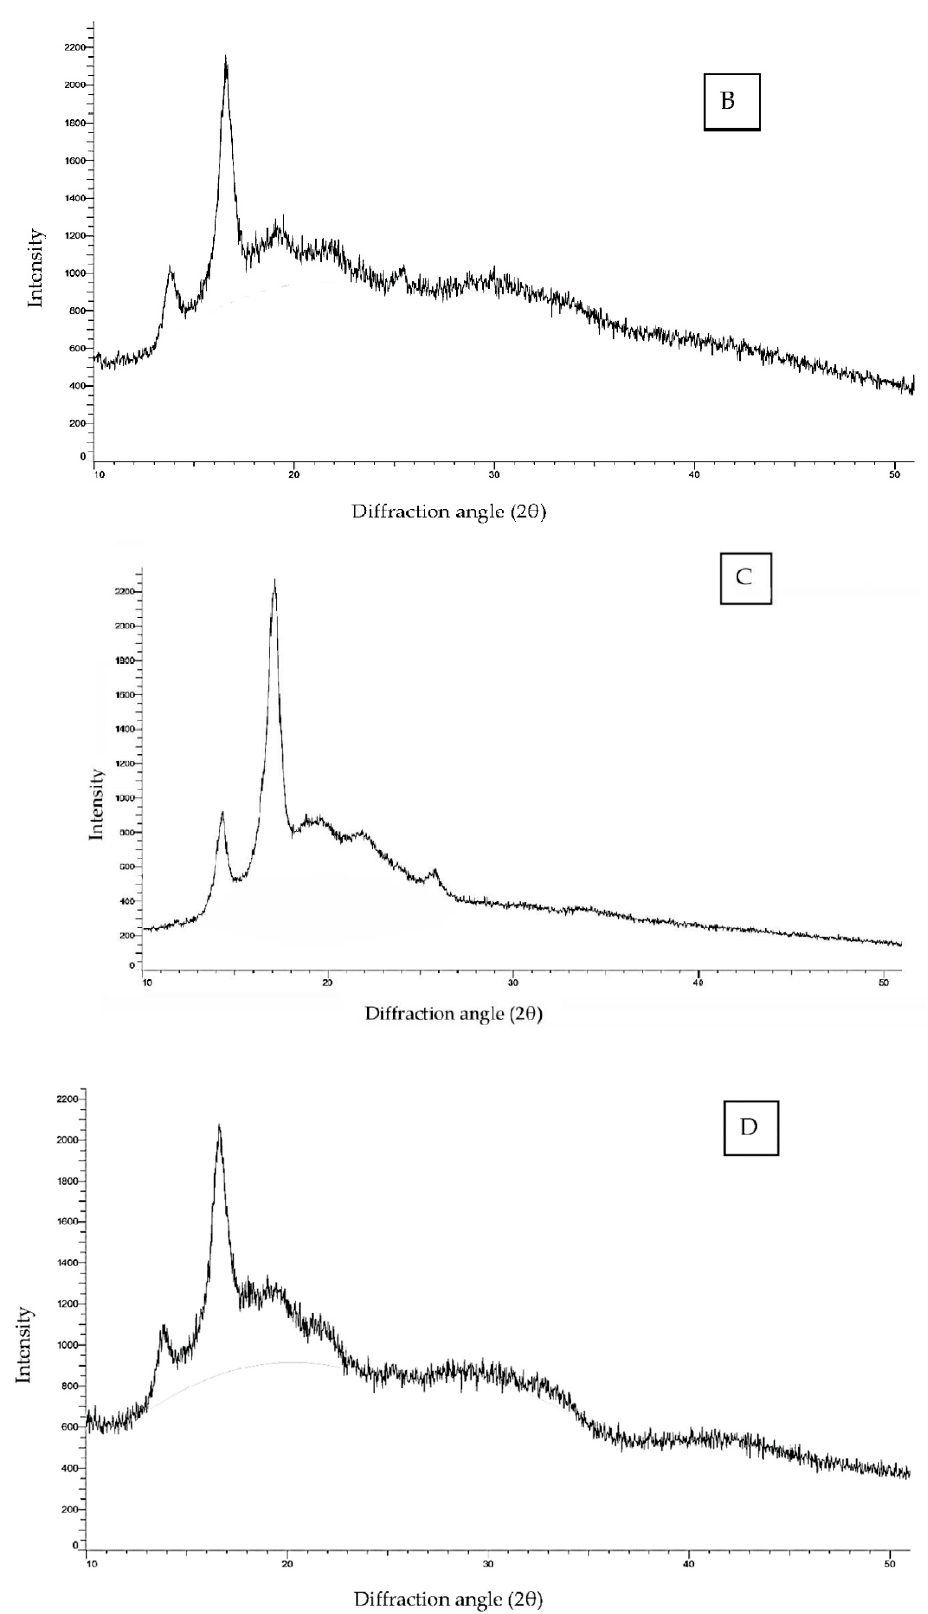
Figure 2. XRD spectra of native and cross ‐ linked lotus seed starch. ( A ) Native LS, ( B ) CL ‐ LS ‐ 1, ( C ) CL ‐ LS ‐ 3, ( D ) CL ‐ LS ‐ 5.